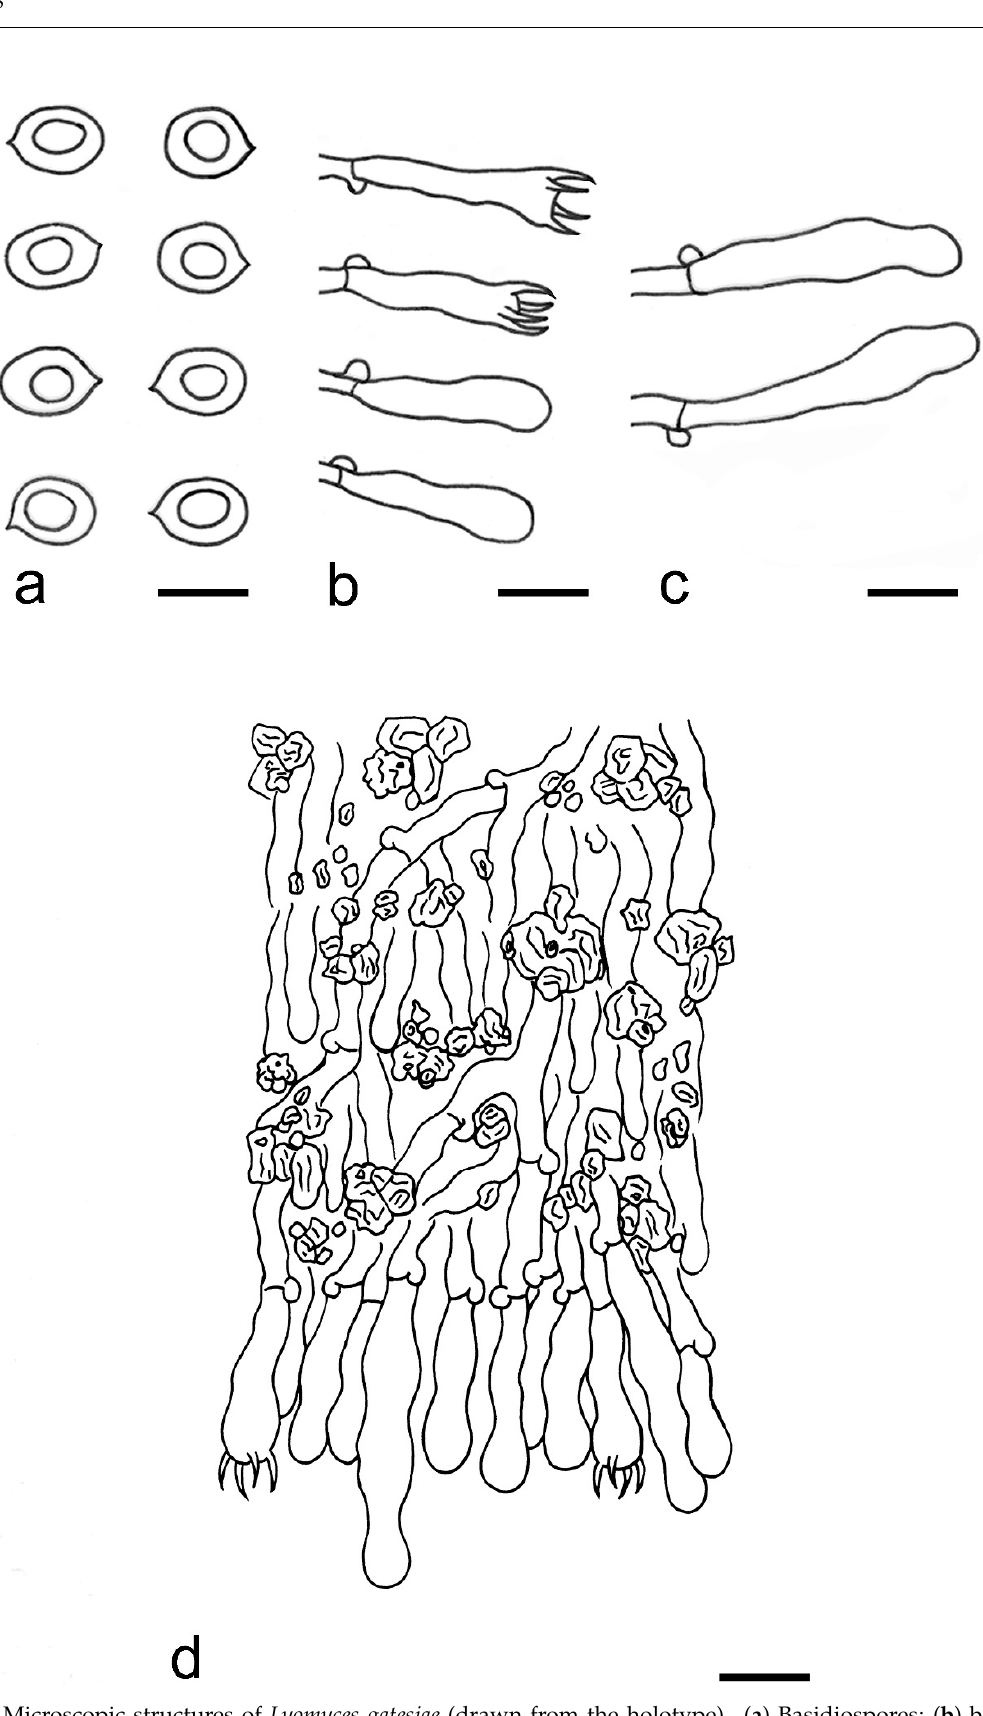
Figure 17. Microscopic structures of Lyomyces gatesiae (drawn from the holotype). ( a ) Basidiospores; ( b ) basidia and basidioles; ( c ) cylindrical, subcapitate cystidia; ( d ) a section of the basidiocarp.—Scale bars: a = 5 μ m; b–d = 10 μ m.